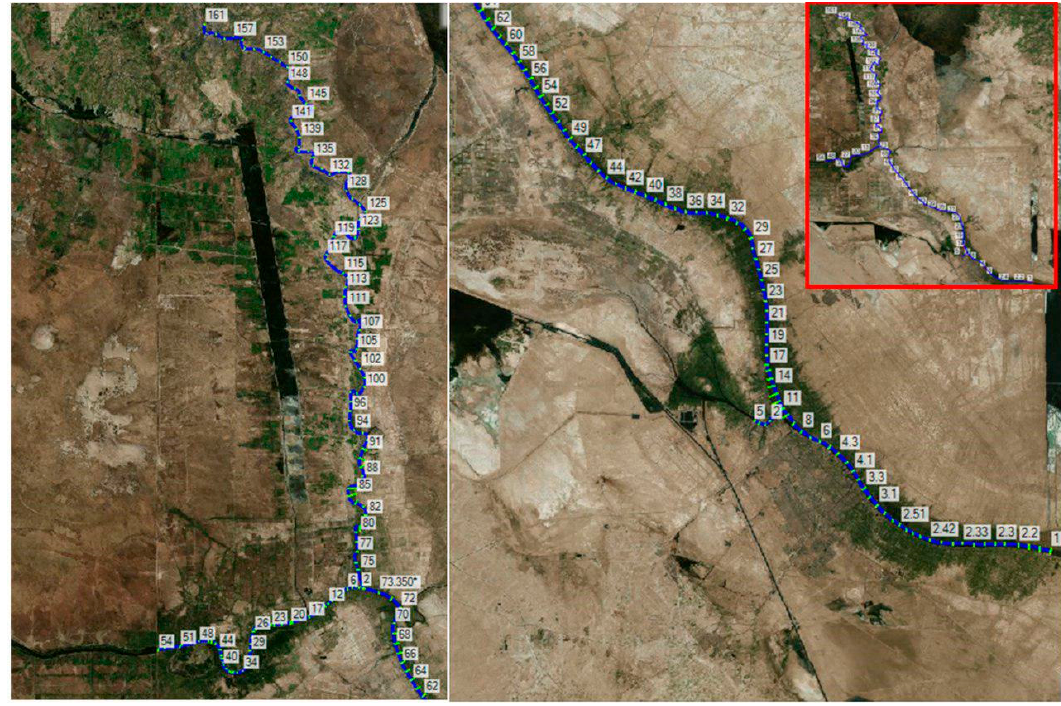
Figure 3. Cross sections of the study area.